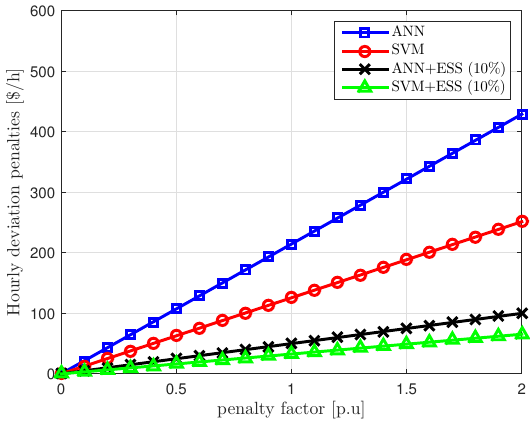
Figure 14. Hourly deviation penalty with a tolerance limit of